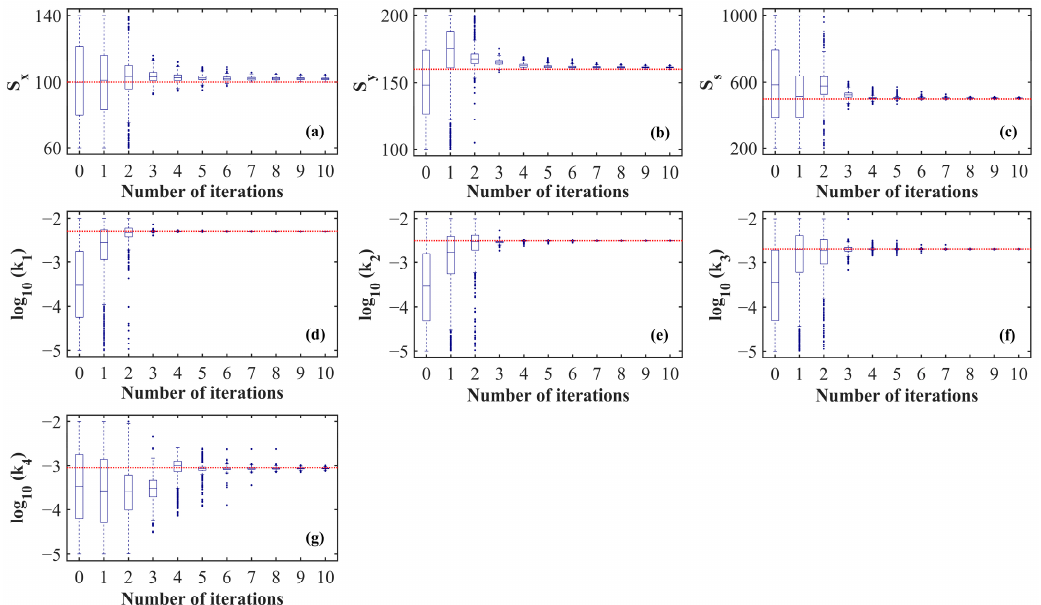
Figure 12. Box plots of model parameters estimated by ensemble smoother with multiple data assimilation ( ES-MDA) in Case 3: ( a , b ) source location ((cid:1845) (cid:3051) ,(cid:1845) (cid:3052) ) , ( c ) source strength ((cid:1845) (cid:3046) ) , ( d – g ) the four rate constants ((cid:1863) (cid:2869) ,(cid:1863) (cid:2870) ,(cid:1863) (cid:2871) ,(cid:1863) (cid:2872) ) . The red dashed lines denote the reference true values of corresponding model parameters.